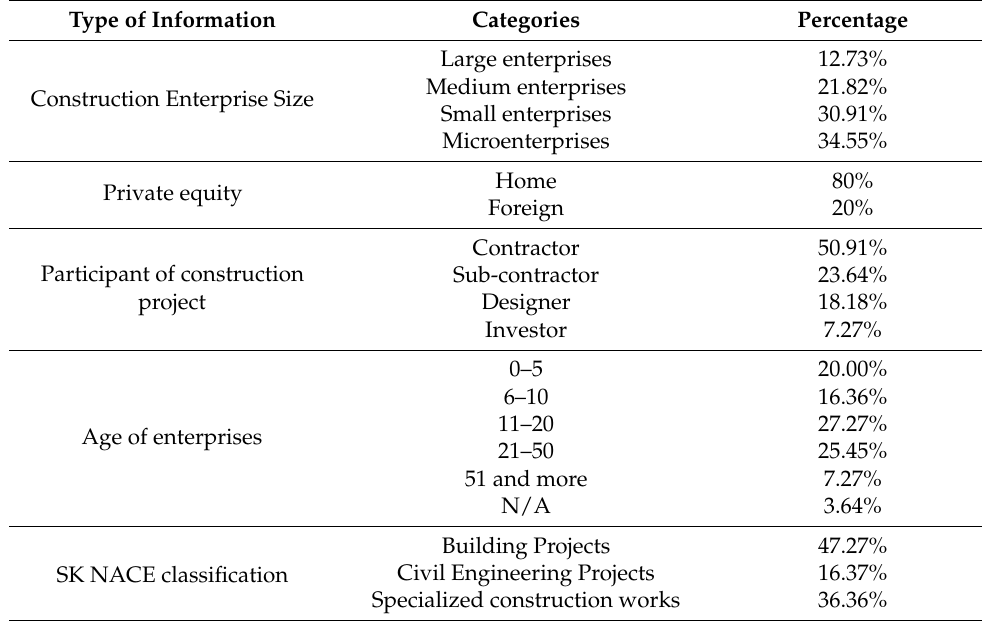
Figure 1. Research step line. Table 1. Literature review of previous surveys in SCM and BD concept